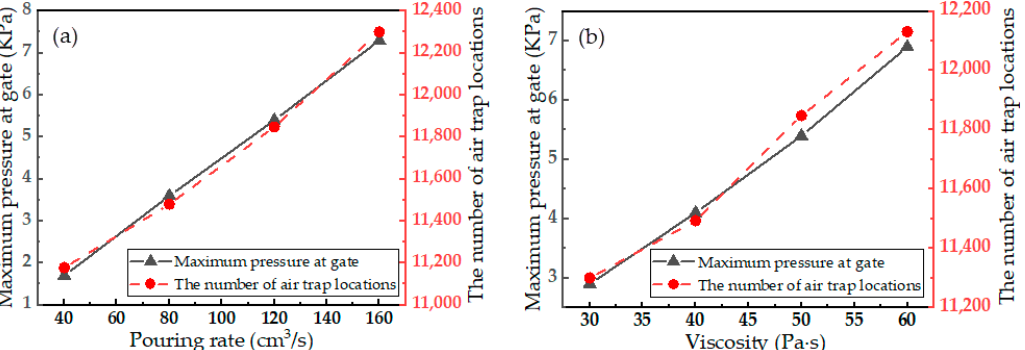
Figure 7. Variation in maximum pouring pressure and number of air trap locations as a function of ( a ) pouring rate and ( b ) resin viscosity.